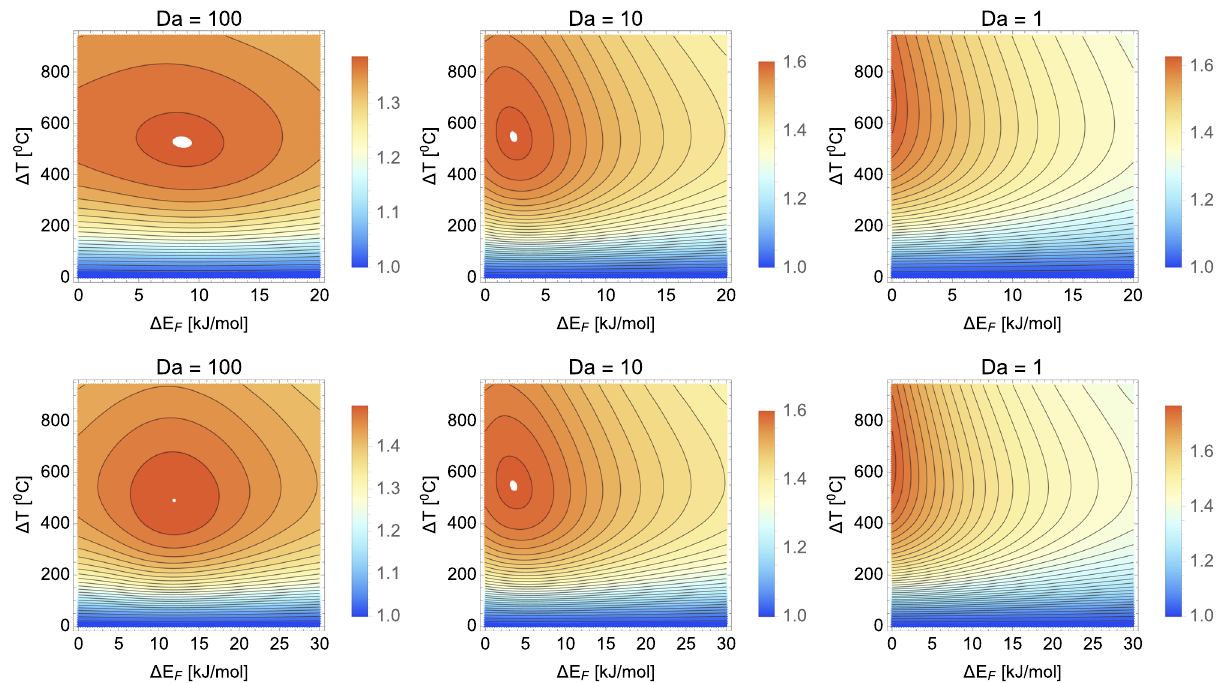
Fig. 5 Furanose selection is maximum for speci fi c values of the temperature gradient depending on kinetic parameters. Density plots of the normalised selection indicator R , Eq. (7), in the ( Δ T , Δ E F ) plane computed from the steady-state solutions of the continuum model (5) for different values of the sel Damköhler number Da = μ / DL 2 . The temperature pro fi le is T ( x ) = T 1 + Δ Tx / L . Top panels: Δ E P = 20 kJ/mol. Bottom panels: Δ E P = 30 kJ/mol. Other parameters as in Fig.